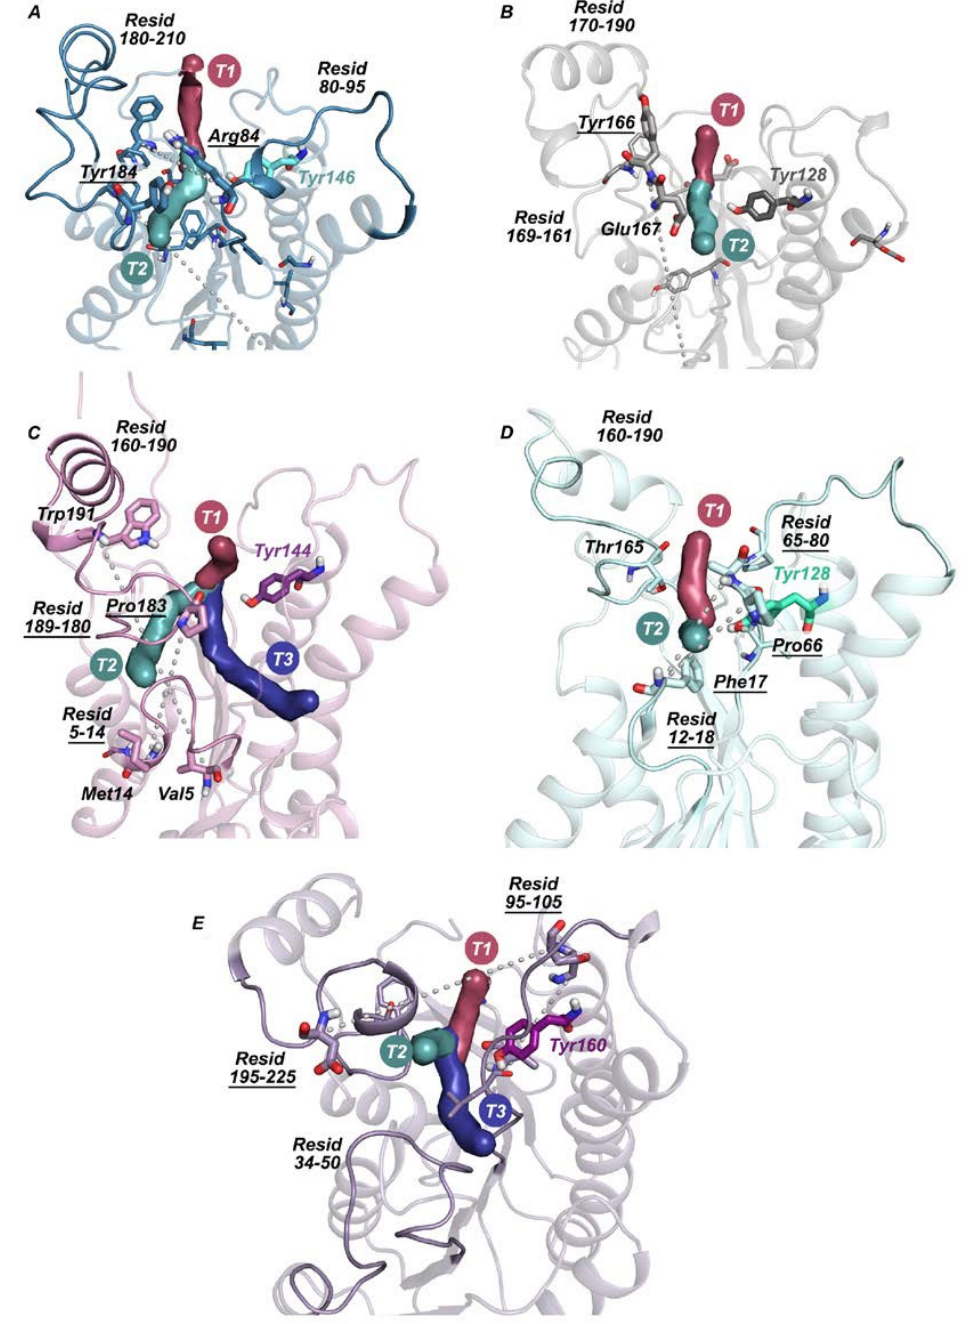
Figure 4. Representation of the three major tunnels that exist in ( A ) HheA2, ( B ) HheB, ( C ) HheC, ( D ) HheD2, and ( E ) HheG: T1 shown in raspberry, T2 in teal, and T3 in dark blue. The key elements that determine T2 formation in the different subclasses are highlighted.